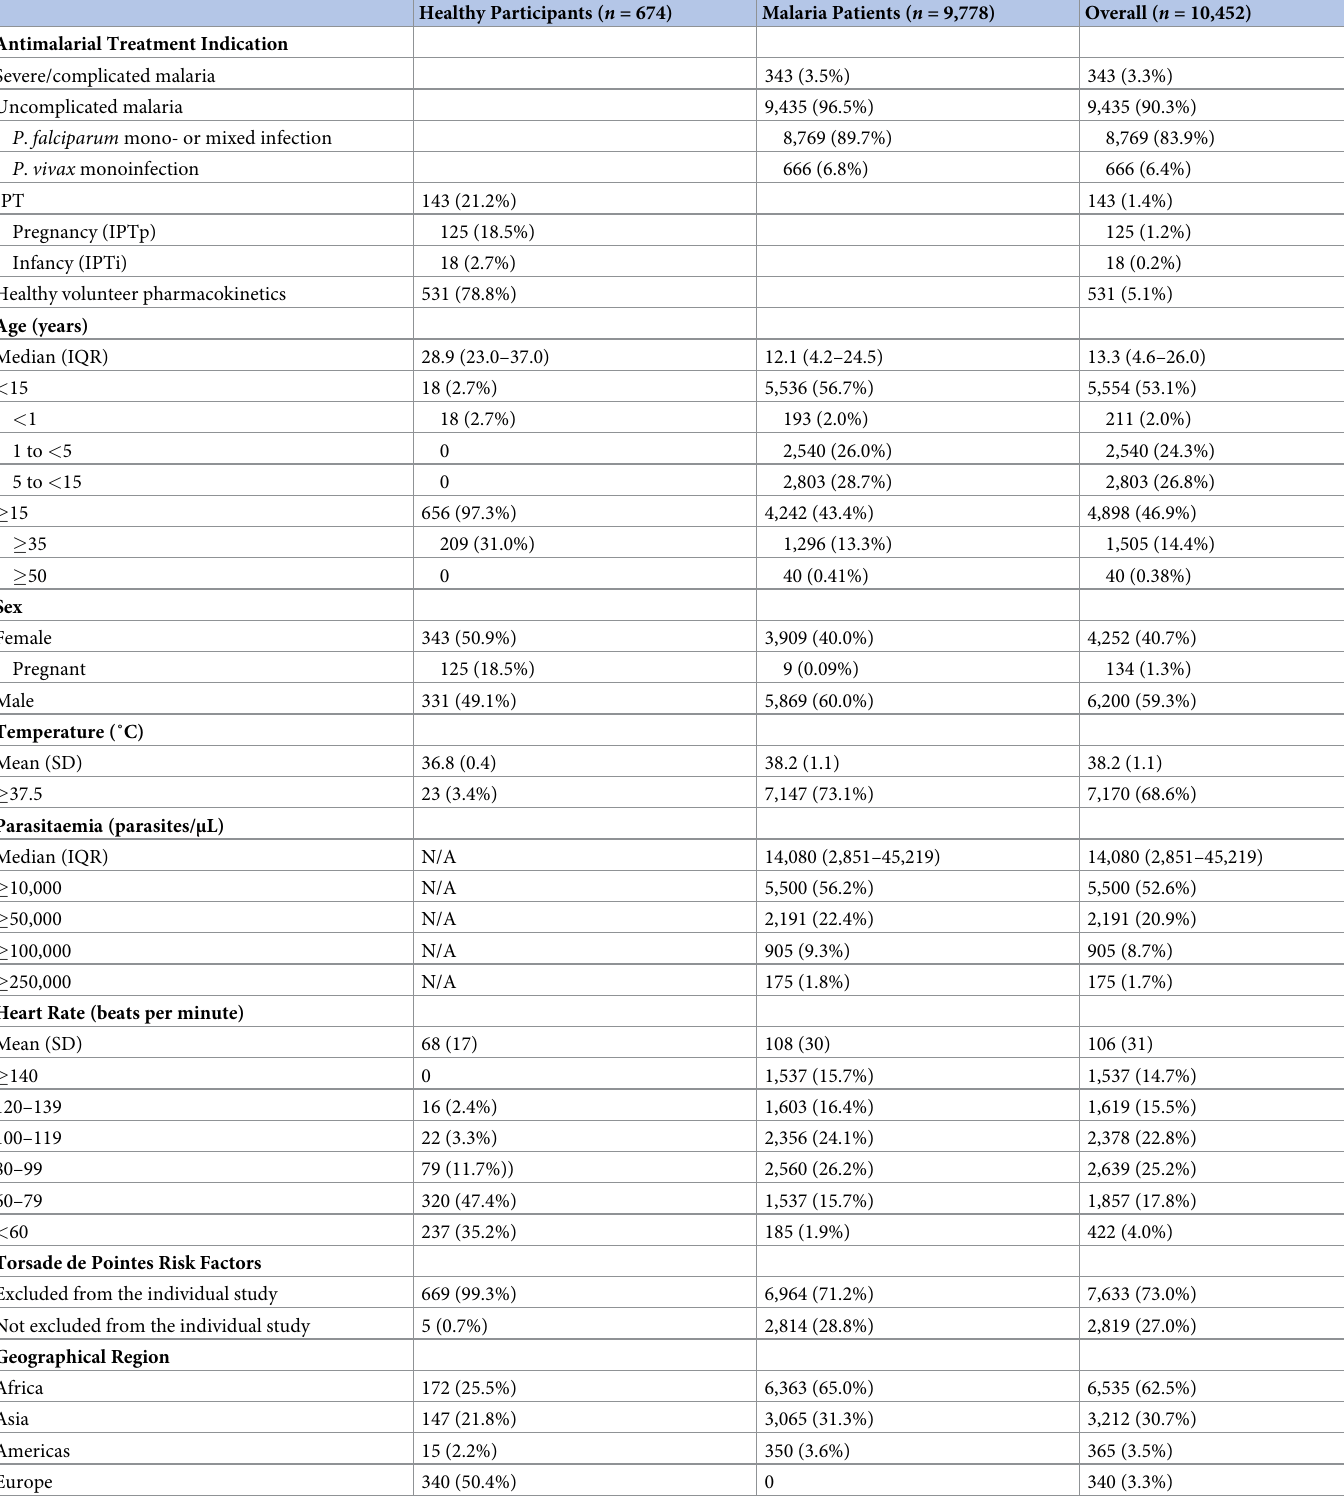
Table 1. Demographics and population